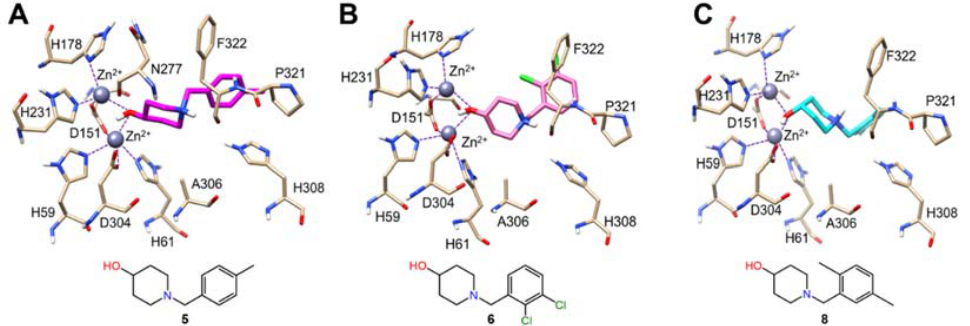
Figure 5. Predicted intermolecular interactions between Ba DHOase and compounds 5 , 6 and 8 from molecular docking. ( A ) Compound 5 , ( B ) 6 and ( C ) 8 are shown in the active site in magenta, pink and cyan, respectively. Intermolecular interactions are indicated with a dashed line to each Zn(II) ion.